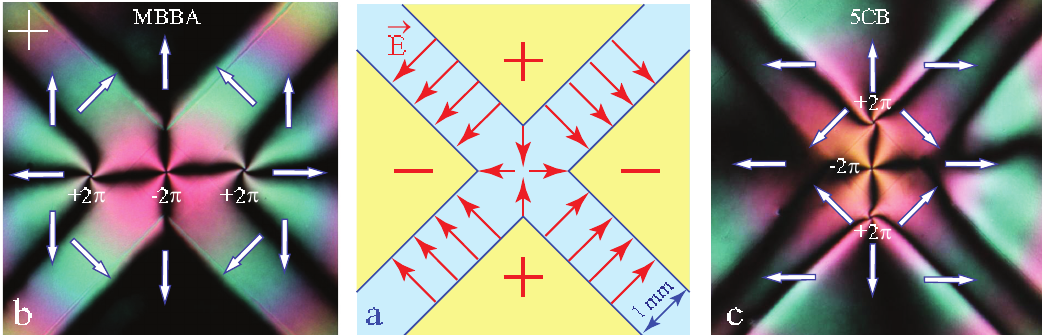
Figure 18. Stable configurations of a dowsons’ triplet in a quadrupolar electric field. ( a ) Electric field